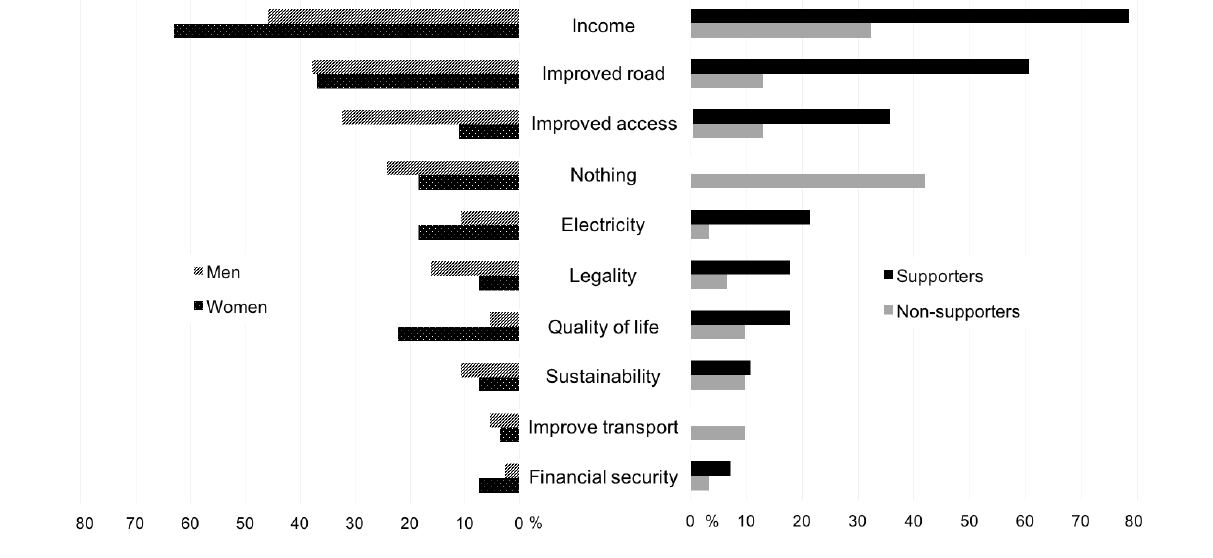
Fig. 2. Free list results comparing positive perceptions of the logging project between project supporters and nonsupporters and between men and women in Chico Mendes Extractive Reserve, Acre,